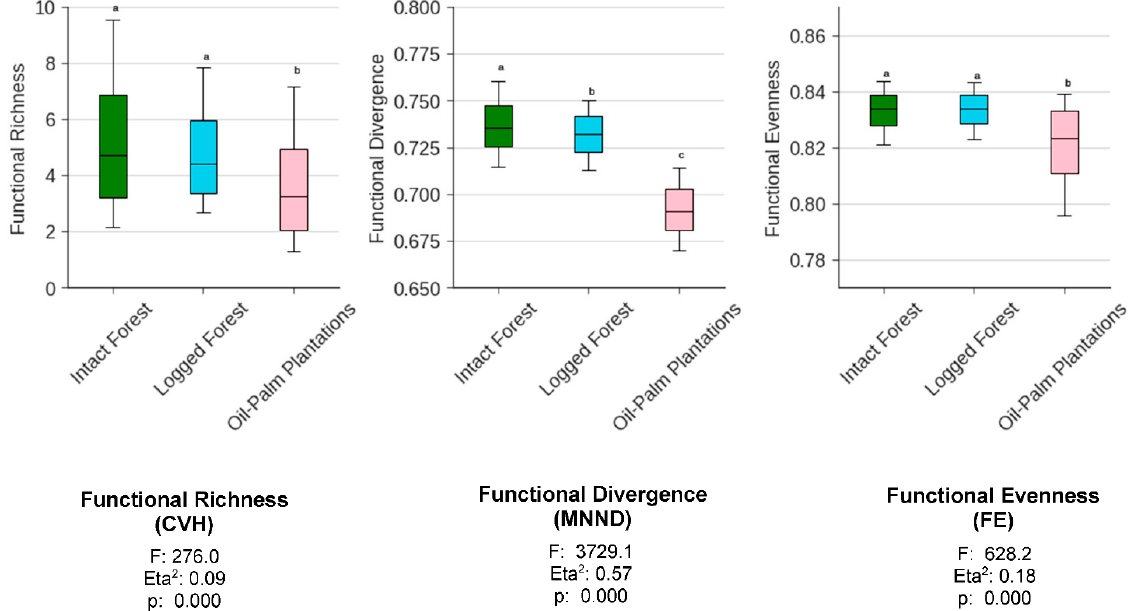
Figure 2. Differences in functional diversity metrics across land-use types are displayed in boxplots with the corresponding ANOVA results. The boxplots’ boxes represent the 25th, 50th, and 75th percentiles and the whiskers depict the 10th and 90th percentiles. The annotated letters (a, b, c) indicate the significance of pairwise differences in retrieved trait estimates between land-use types according to post hoc Tukey’s HSD tests. Table 1. Descriptive statistics per functional diversity metric across land-use types in Sabah. N